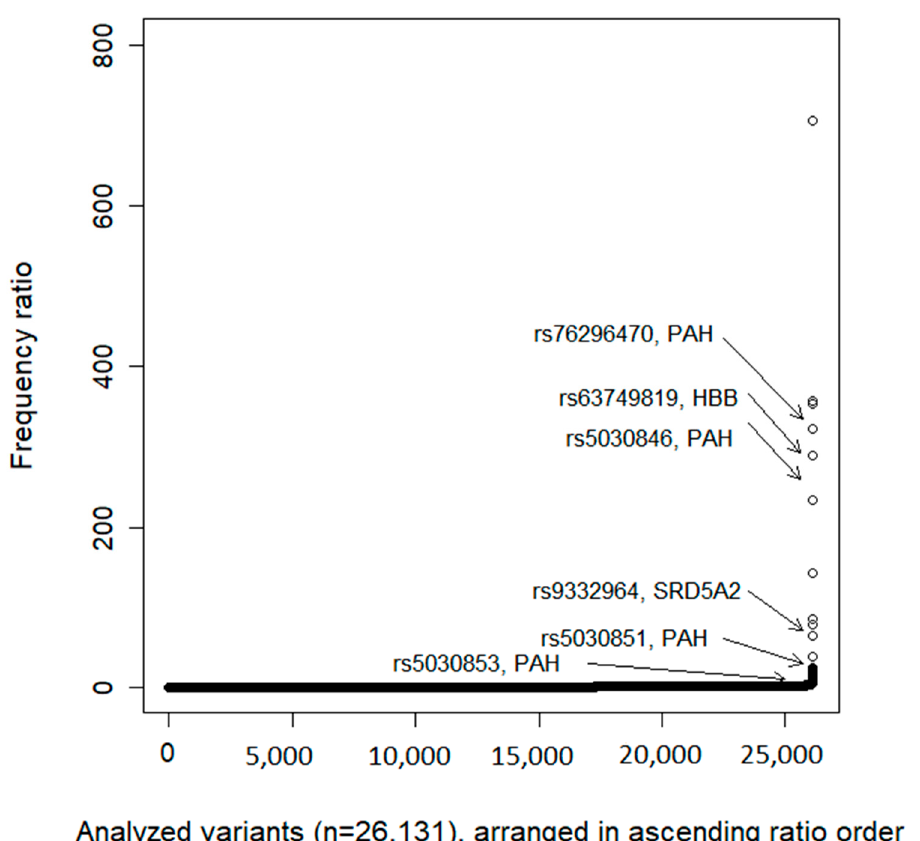
Figure 1. Ratios of the estimated population frequencies in ancient samples [39] and their contem- porary frequencies [38] of all disease-associated variants from the DisGeNet platform, arranged in ascending ratio order. Arrows point to the position of unequivocally pathogenic variants considered in this study. The genes these variants are constituent of are also